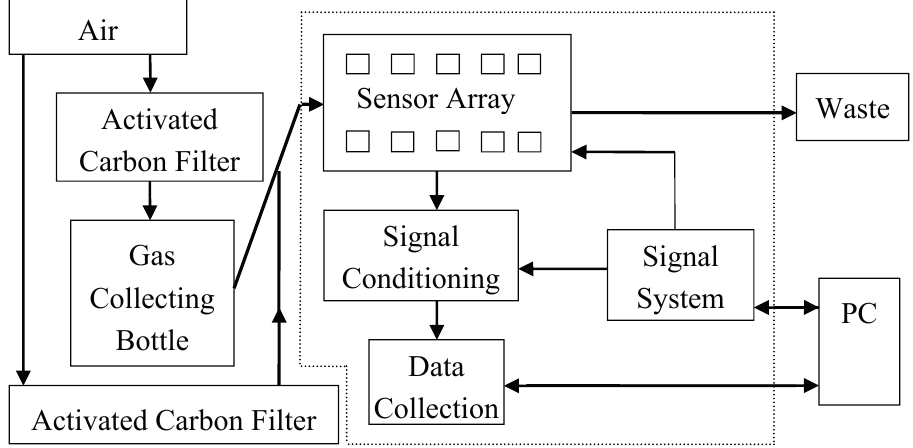
Figure 1. The structure of the electronic nose